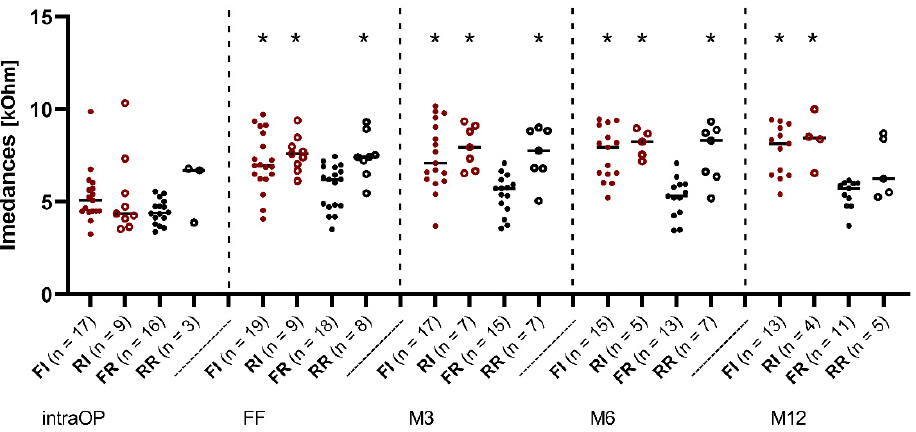
Figure 4. Change in impedances over time re-implantation vs. first implantation in the IES and REGULAR groups. Median over all electrode contacts C1–C12. The filled red dots represent the patients from the IES group who received first implantation (FI) and the hollow red dots represent the patients from the IES group who underwent re-implantation (RI). The filled black dots represent the patients with first implantation from the REGULAR group (FR) and the hollow black dots represent the patients who underwent re-implantation from the REGULAR group (RR). Asterisks mark significant differences between groups.